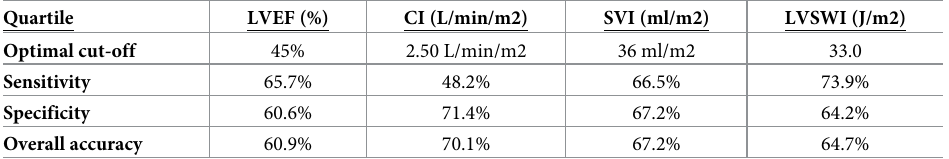
Table 4. Optimal cut-off (maximum value of Youden’s J index = sensitivity + specificity– 1) with the associated sensitivity, specificity and overall accuracy for selected echocardiographic variables for prediction of in-hospital mortality using univariable logistic